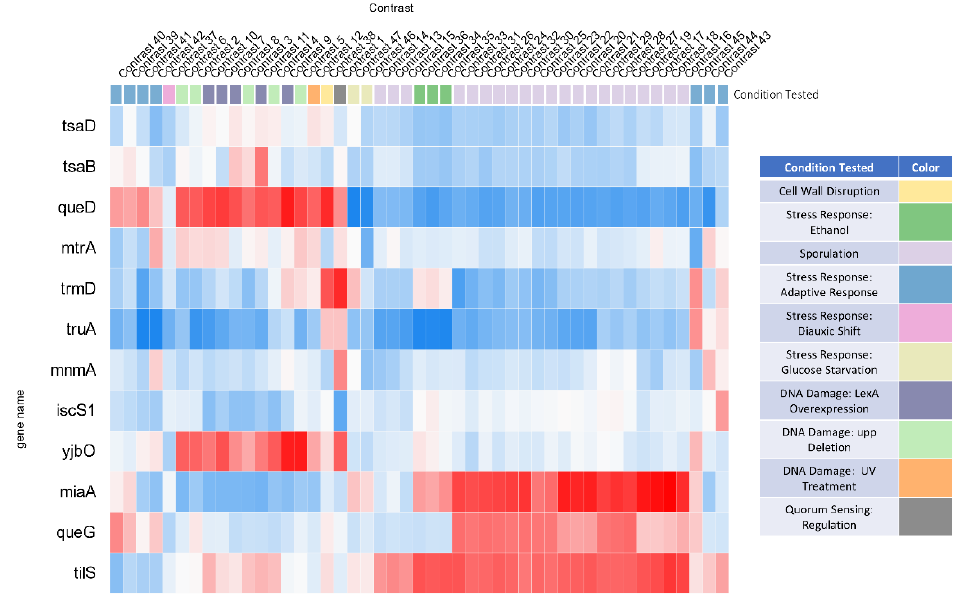
Figure 6. Most dramatic observed expression changes for tRNA modification genes. A subset of genes with dramatic shifts in expression levels across 47 contrasts were selected to create a separate heatmap. Genes with increased expression levels are shown in red and genes with decreased expression levels are shown in blue. The gene names are shown on the left axis and the contrasts are listed on the top axis. See Table S5 for the complete data and the lists of conditions.